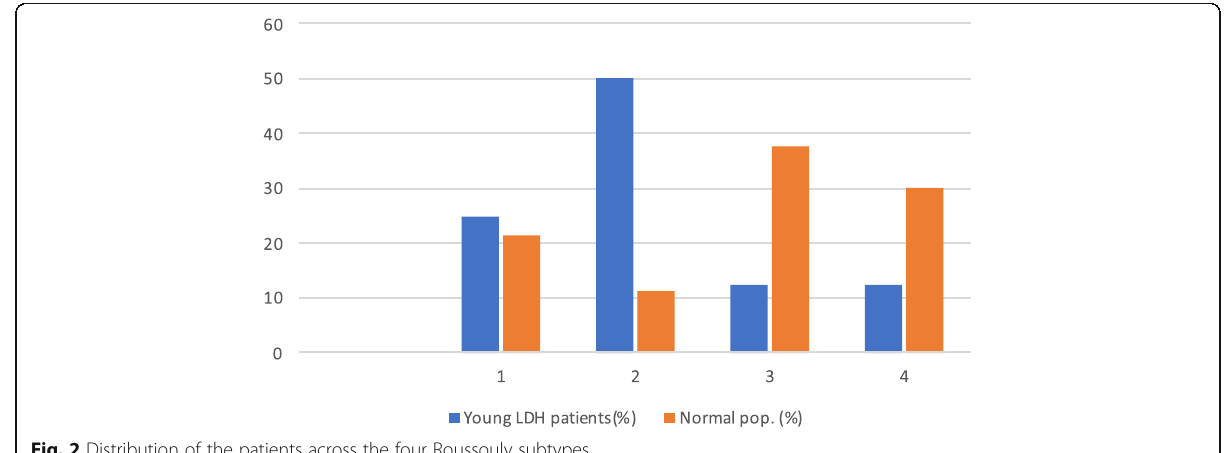
Fig. 2 Distribution of the patients across the four Roussouly